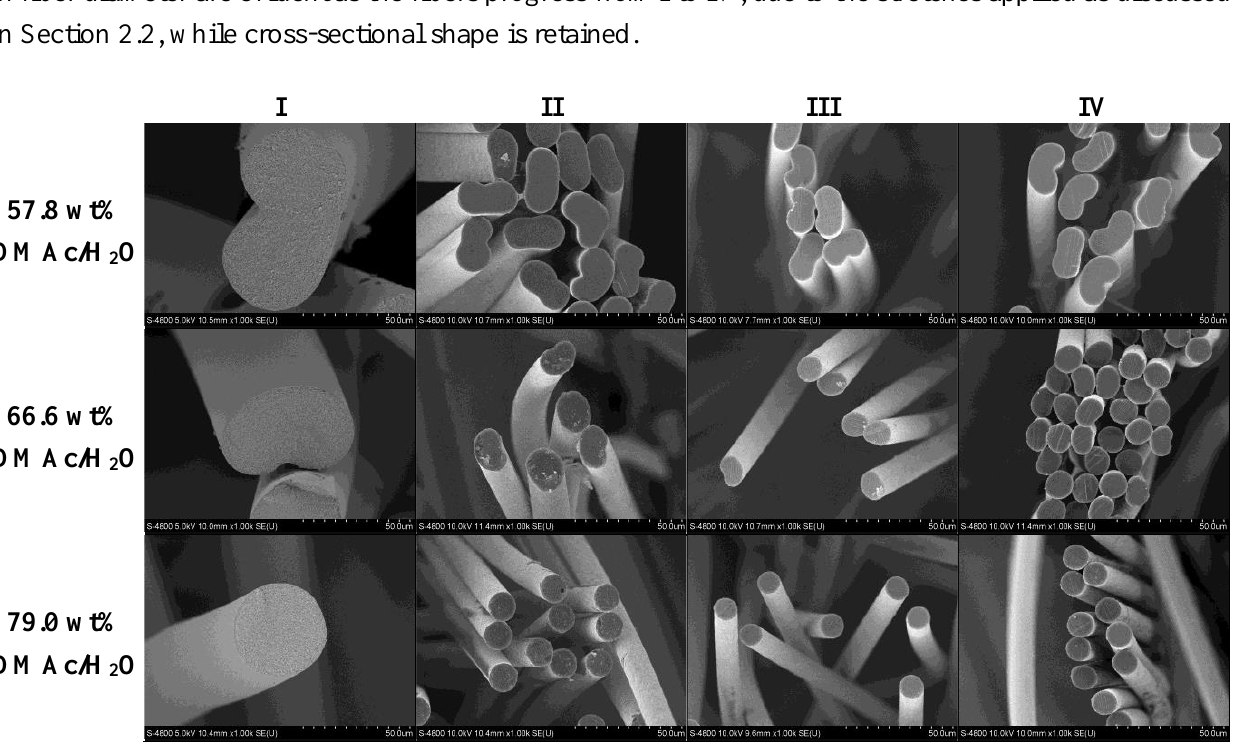
Figure 7. Effect of coagulation bath composition on fiber shape and size as the fiber progresses down the spinning